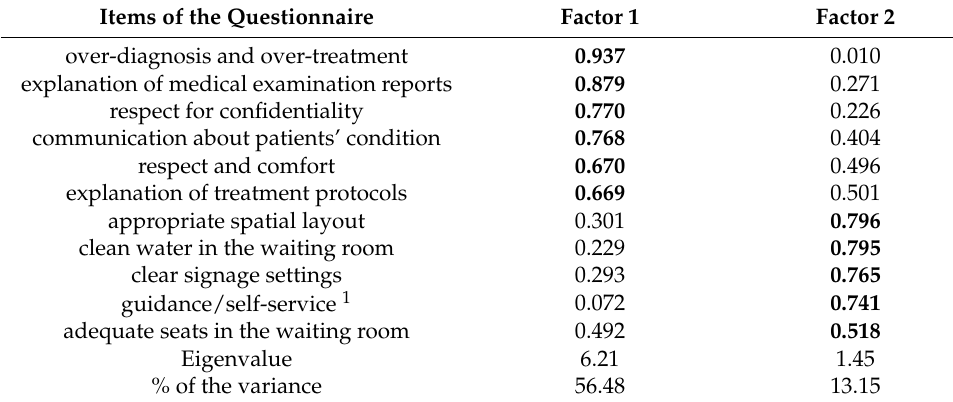
Table 2. Validation of the measurement models.